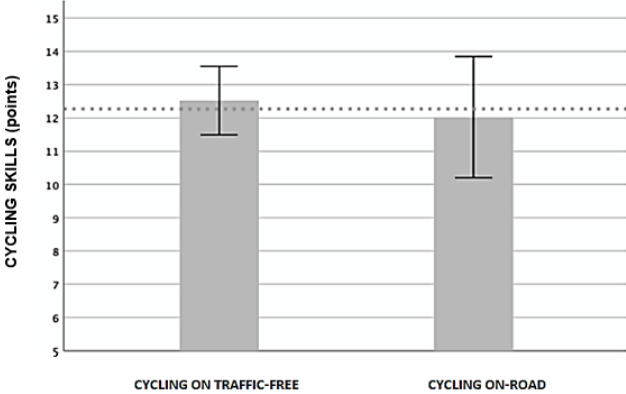
Figure 3. Changes on the cycling knowledge at baseline and at follow up on the cycling group.